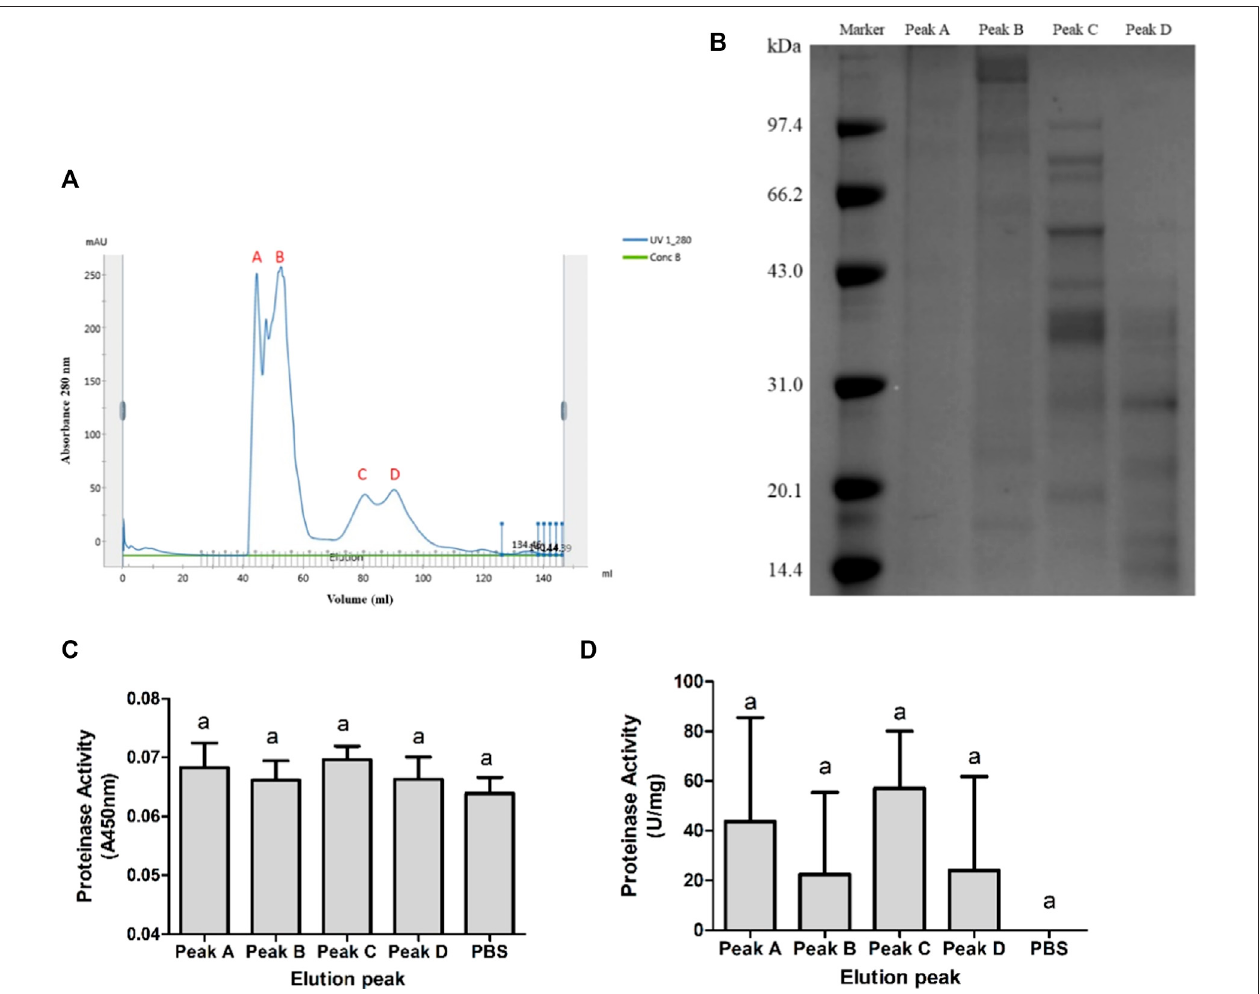
FIGURE4| Superdexchromatographypuri fi cationof0.2 MNaCl – elutedfraction. (A) Elutionpeaksof0.2 MNaCl – elutedfractionpuri fi edbySuperdex75.PeaksA and B were well separated from C and D. But components in AB and CD were not entirely separated. (B) Nonreducing SDS-PAGE of each fraction. Protein bands of C and D were similar and more clear than those of A and B. (C,D) Proteinase activity of each fraction showed by A450 nm and U/mg. None of the four fractions showed signi fi cant proteinase activity, p < 0.05.